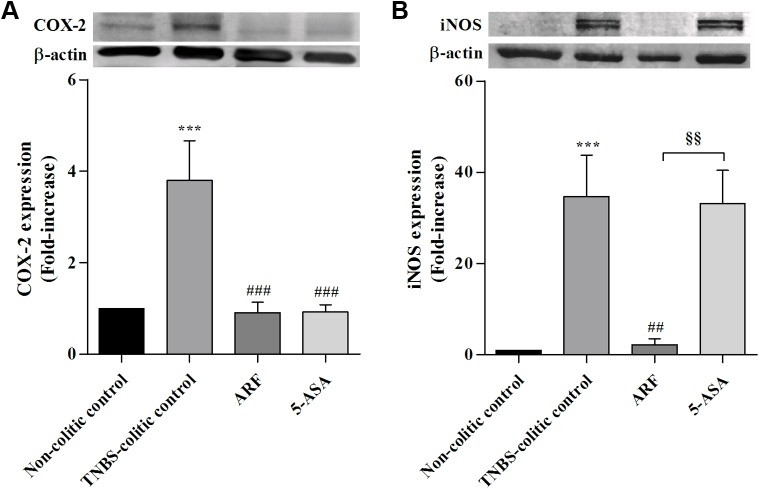
Comparison of the effects of anthocyanin-rich fraction and 5-ASA on COX-2 and iNOS protein expressions in colon tissue samples of colitic rats.COX-2 (A) and iNOS (B) protein expressions were evaluated by Western blotting in each animal of each group and expressed as fold increase relative to the non-colitic control group. Values are means ± SEM from of at least 8–9 animals per group, each one in duplicate. ***P<0.001 vs non-colitic control; ##P<0.01, ###P<0.001 vs TNBS-colitc control; §§P<0.01 vs 5-ASA group.